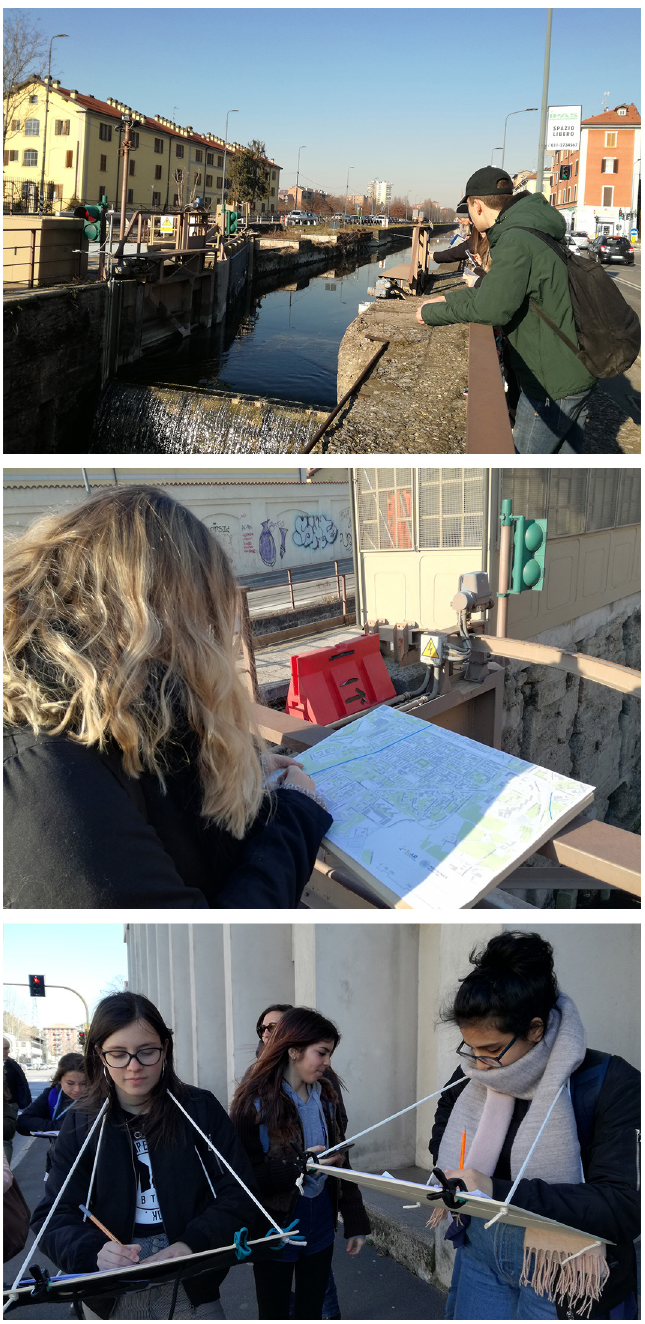
the buildings and the places touched by the learning